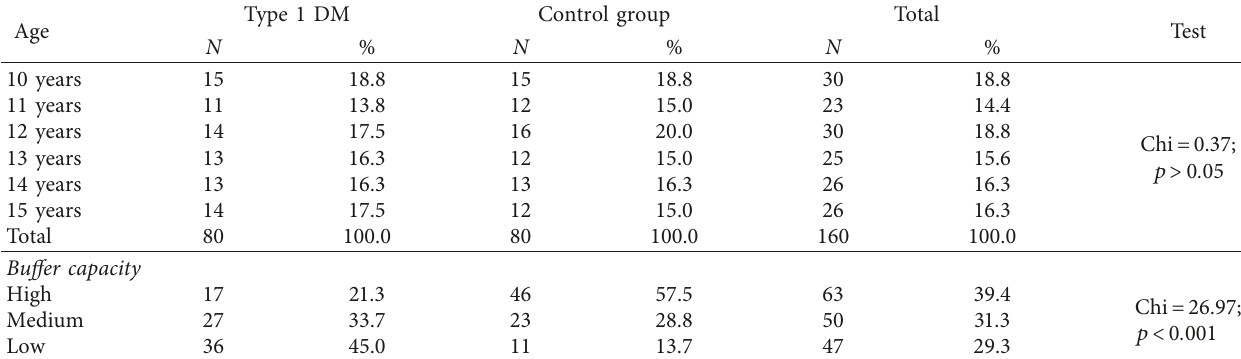
Table 1: The differences in age and buffer capacity between groups.